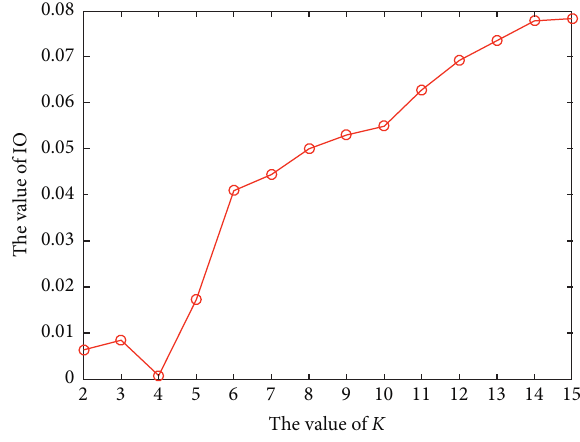
Figure 5: IO values of different K .